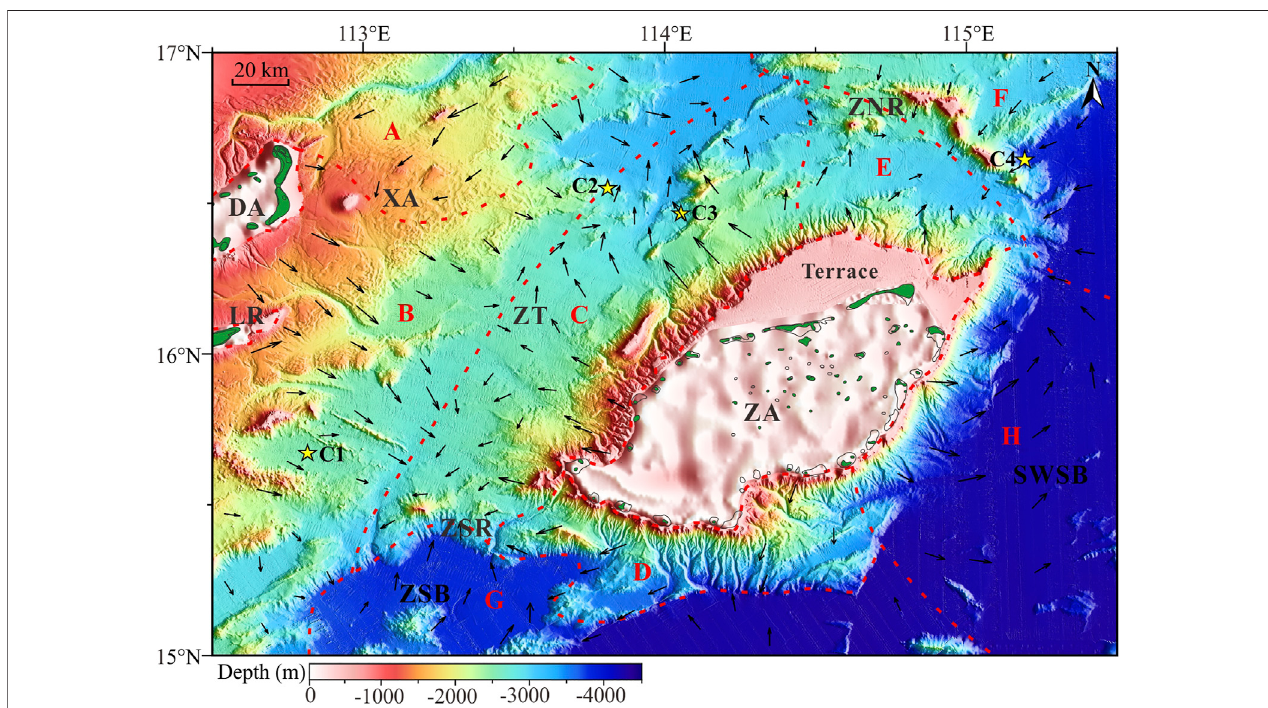
FIGURE4| Netsedimenttransporttrends wererevealedbytheGSTAinthestudy area.Vectordirectionsweredividedintoeight zones(Zone A – H )byred dashed lines. Black vector arrows indicate the sediment transport directions. The vector length suggests the signi fi cance of grain size trends and has no signi fi cance in depositional rates. Yellow stars indicate the position of four ADCP stations.